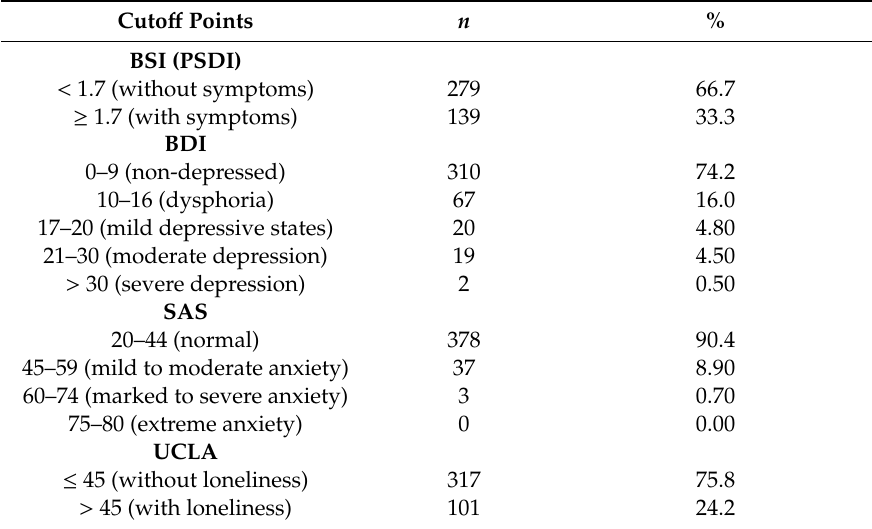
Table 15. Sample frequencies of dependent variables based on cuto ff points. Cuto ff